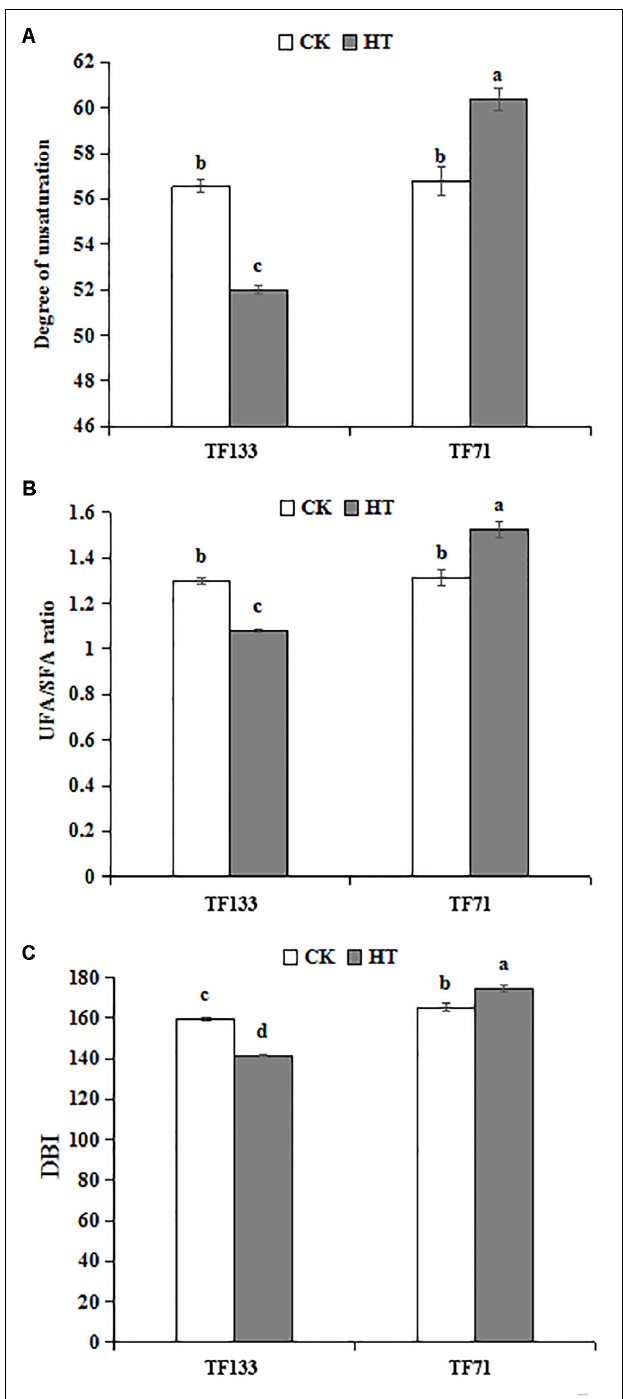
FIGURE 5 | Changes of degree of unsaturation (A) , the ratio of UFA to SFA (B) , and double bond index (DBI) (C) in tall fescue leaves in heat-sensitive genotype “TF133” and heat-tolerant genotype “TF71” under normal conditions or heat stress. CK was the control (22/18 ◦ C for light/dark), while HT was the heat treatment (40/35 ◦ C for light/dark). All the plants were treated for 1 day. Mean ± SD were calculated from five biological repeats. Different letters indicated statistical difference significance at P < 0.05 among the different treatments groups by Duncan’s multiple range